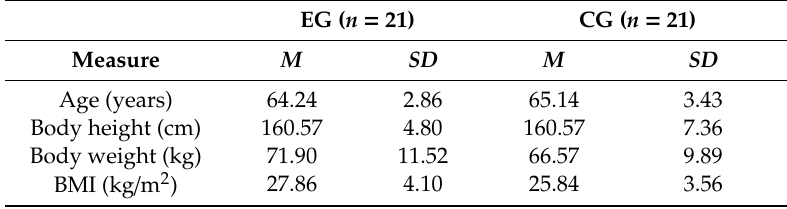
Table 1. Average values and standard deviations for the general characteristics of the participants before the start of the experiment.